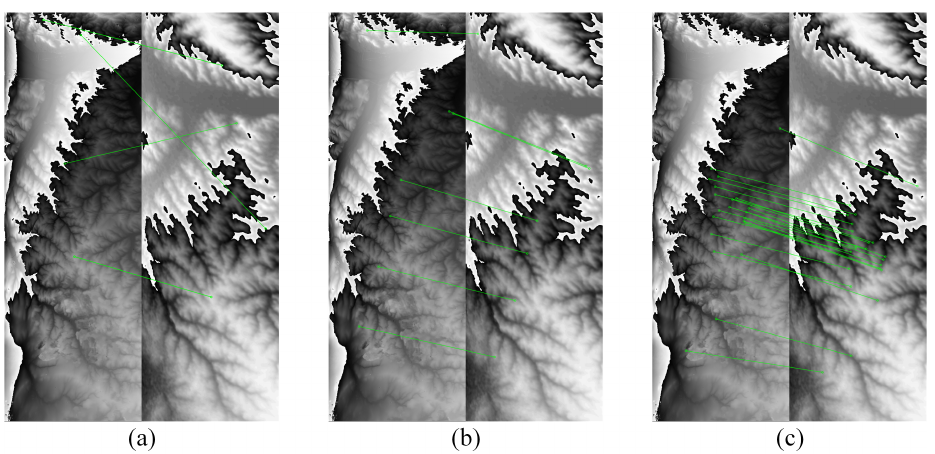
Figure 19. Comparison of interference fringe-matching algorithm results in the attitude error experi- ment. ( a ) SIFT. ( b ) SURF. ( c ) Proposed algorithm.